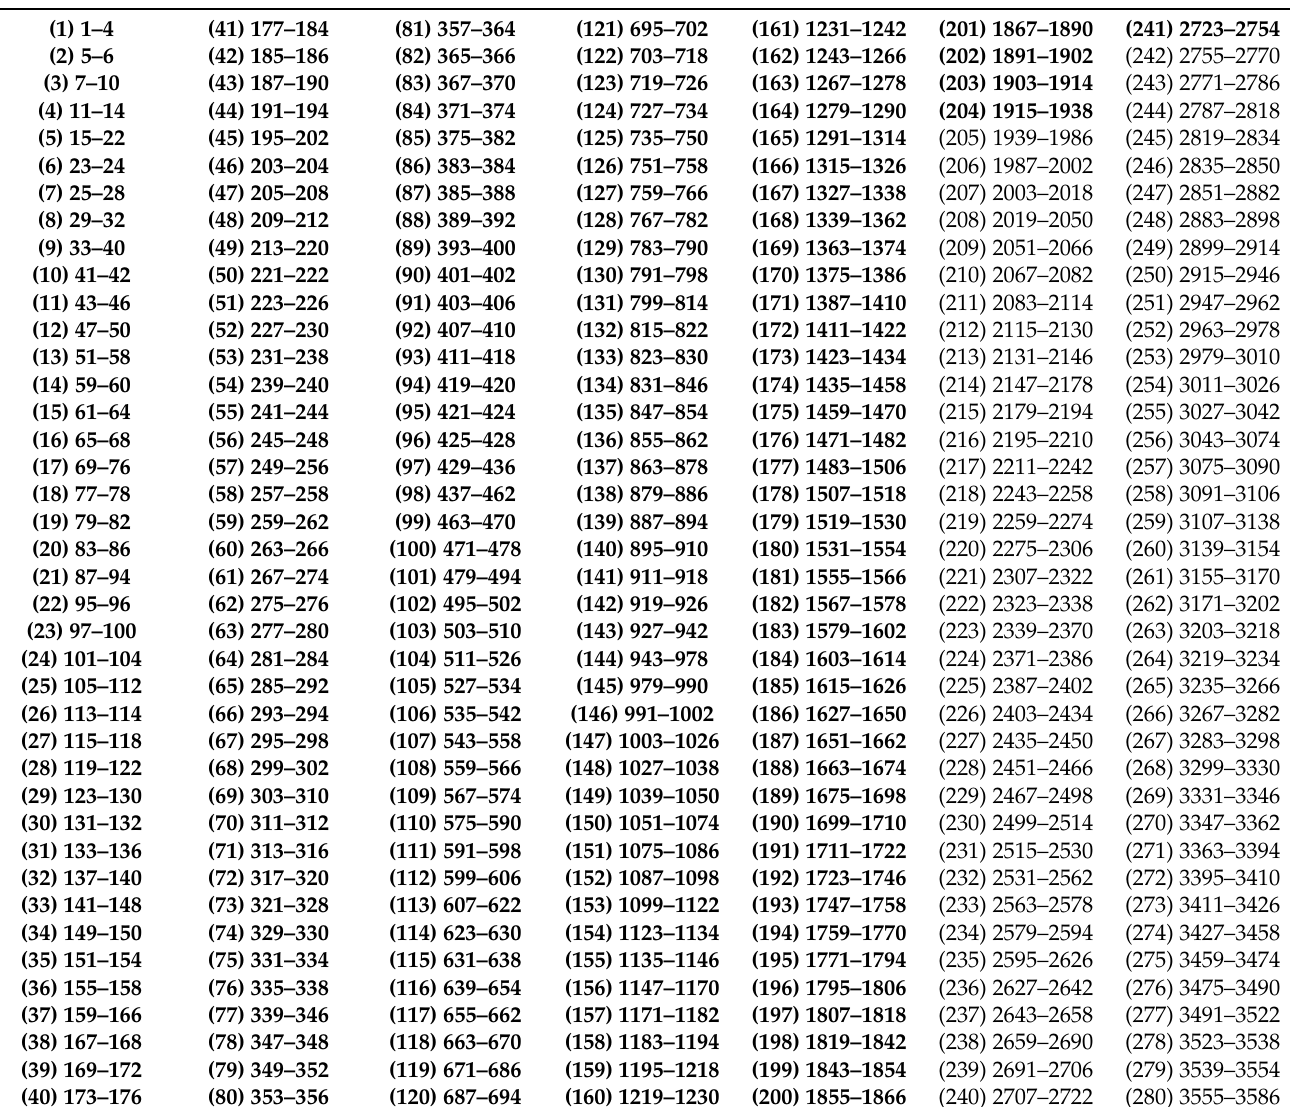
Table A1. Element grouping for the two space towers optimized in this study. Group element numbers are indicated between parentheses. Elements shared by the two towers are typed in